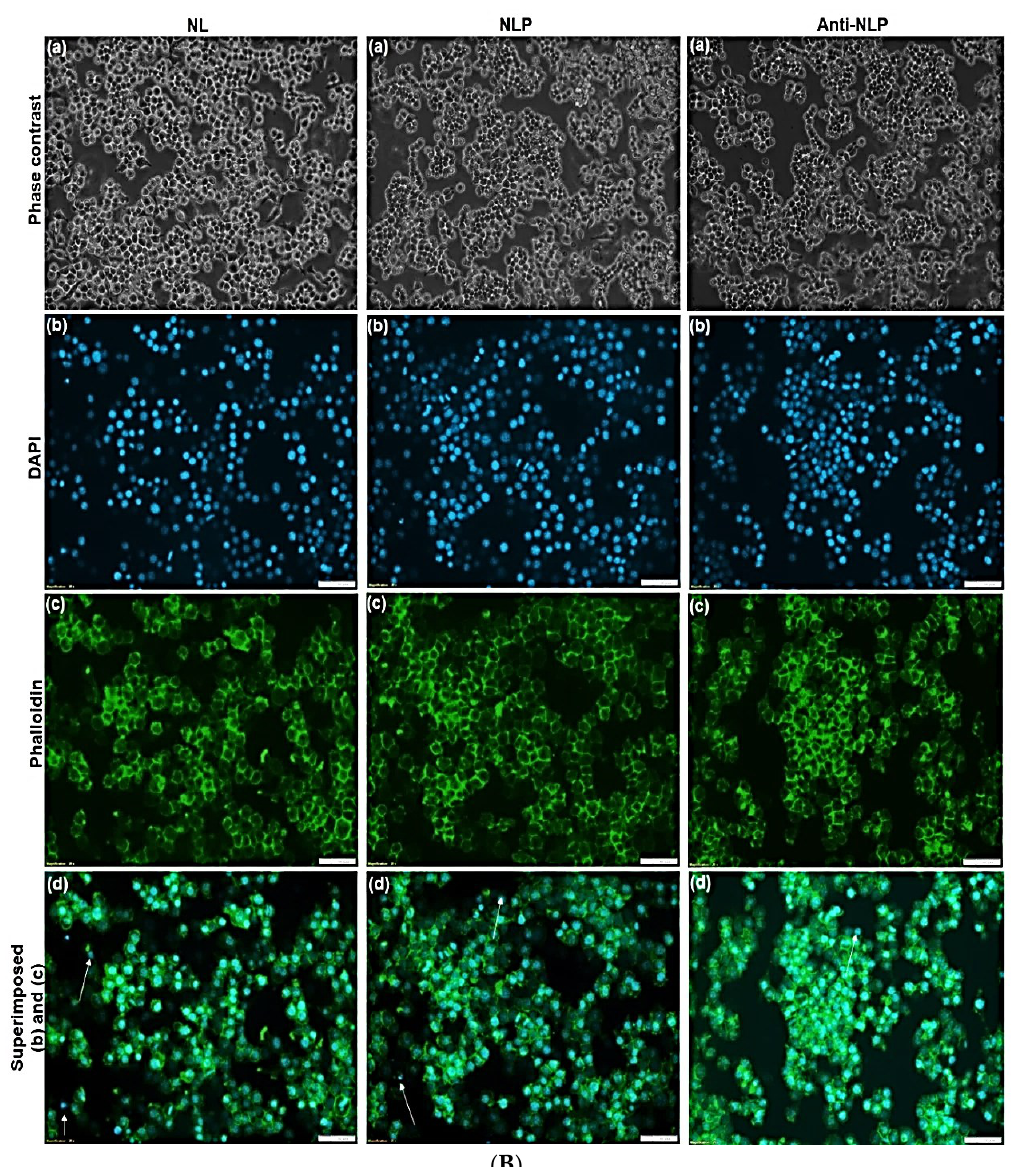
Figure 8. ( A ) Morphology analysis. Fluorescent microscopy images of RAW 264.7 macrophage cell ( a ) Phase contrast, ( b ) DAPI, ( c ) Phalloidin and ( d ) Superimposed of ( b , c ) for untreated (control), cell treated with 90 μ g/mL of PZQ and 5-FU (10 μ g/mL) (negative control). Scale bar: 100 μ m; (×20 magnification). ( B ) Morphology analysis. Fluorescent microscopy images of RAW 264.7 macrophage cell ( a ) Phase contrast, ( b ) DAPI, ( c ) Phalloidin, and ( d ) Superimposed of ( b , c ) with 90 μ g/mL of NL, NLP, and anti-calpain-NLP. Scale bar: 100 μ m; (×20 magnification). Figure 9A,B present the phase contrast morphology of the RAW 264.7 murine macrophage and 3T3 human fibroblast cells visualized by inverted microscopy after the cells were treated with 30 µ g/mL of free PZQ, NLP, and anti-calpain-NLP and 10 µ g/mL of 5-FU as negative control, while using the untreated cells as the positive control. It was observed that all the cells possessed normal cell morphology of RAW 264.7 murine macrophage and 3T3 human fibroblast cells, and they showed active structures due to the appearance of stellate and/or spindle shapes and centrally placed round nucleus or oval, as well as the abundant rough endoplasmic reticulum. However, the cells treated with 10 µ g/mL of 5-FU (negative control) showed cell shrinkage, which resulted in